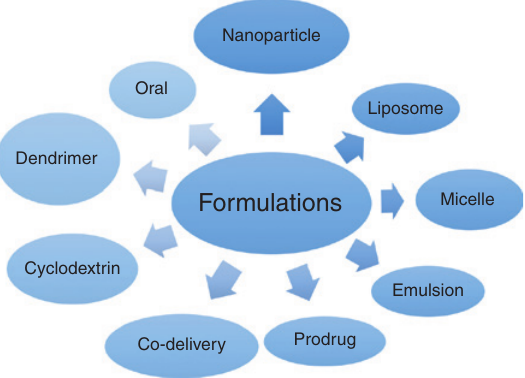
Figure 4: Various formulations for PTX delivery discussed in this review.